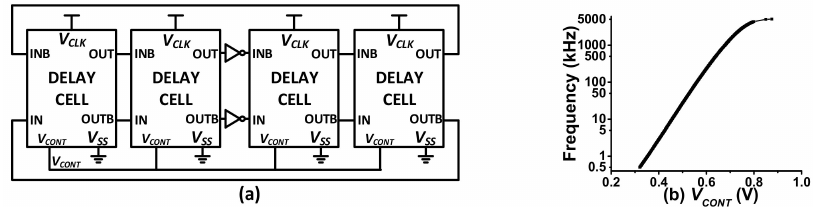
Figure 15. ( a ) Block diagram of leakage-based clock generator. ( b ) Frequency vs. control voltage ( V CONT ).